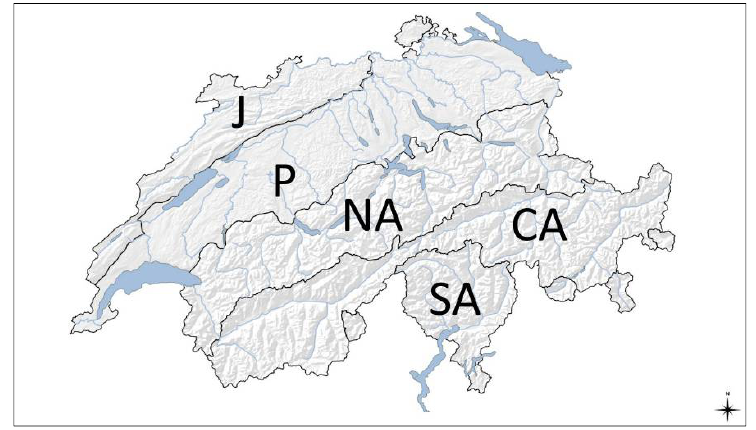
Figure 1. The five biogeographic regions of Switzerland: Jura (J), Plateau (P), Northern Alps (NA), Central Alps (CA), Southern Alps (SA). Adapted from Gutersohn [14].